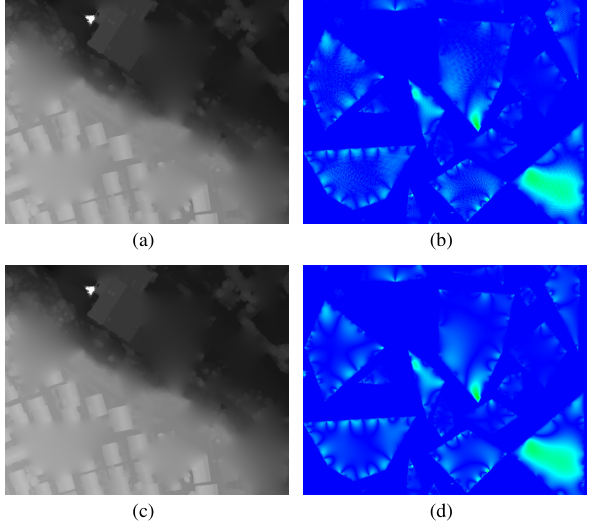
Figure 7. DSM interpolation details after postprocessing with a 31 x 31 Gaussian kernel, 60% valid pixels (a) interpolation for n = 64 , (b) heat map for n = 64 , (c) interpolation for n = 256 , (d) heat map for n = 256 path directions